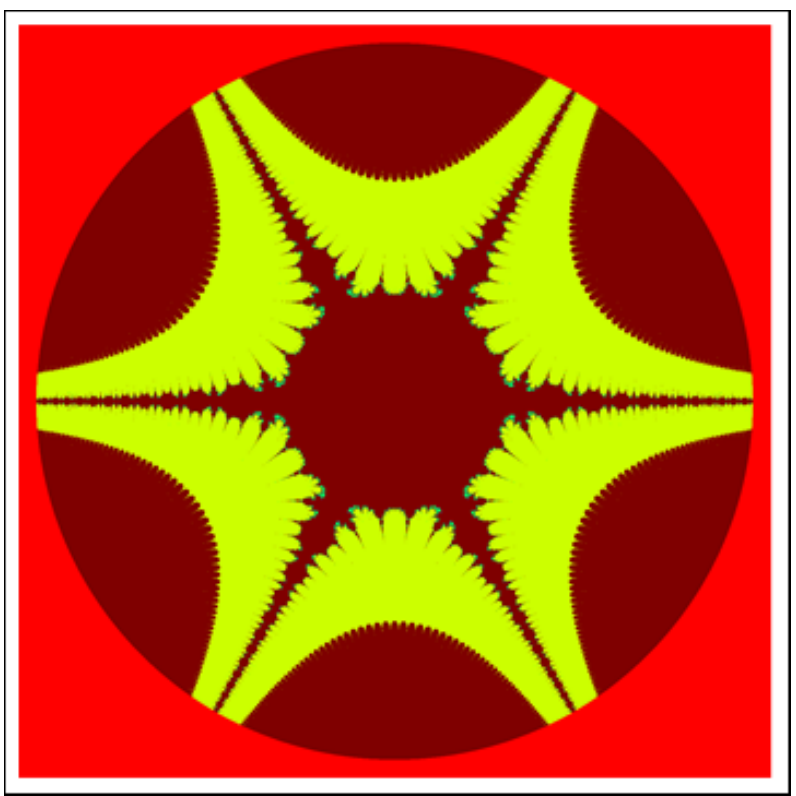
Figure 8. J-set for τ ( z ) = sin ( z 3 ) + c via DKIS. The image execution time is 1077 s.